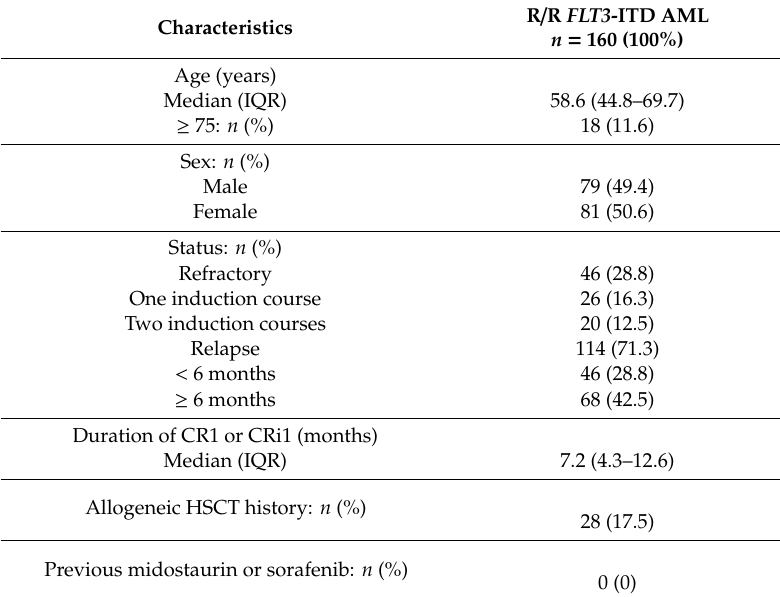
Table 3. Characteristics of patients with R / R FLT3 -ITD AML ( n = 160).